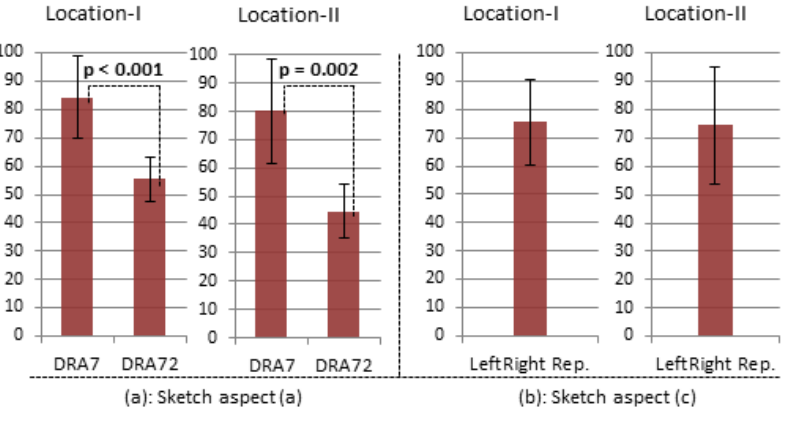
Figure 7: (a) The accuracy rate of matches using the DRA 7 and DRA 72 and p -values repre- sent significant differences in the matching results, (b) the accuracy of matched landmarks using the LeftRight